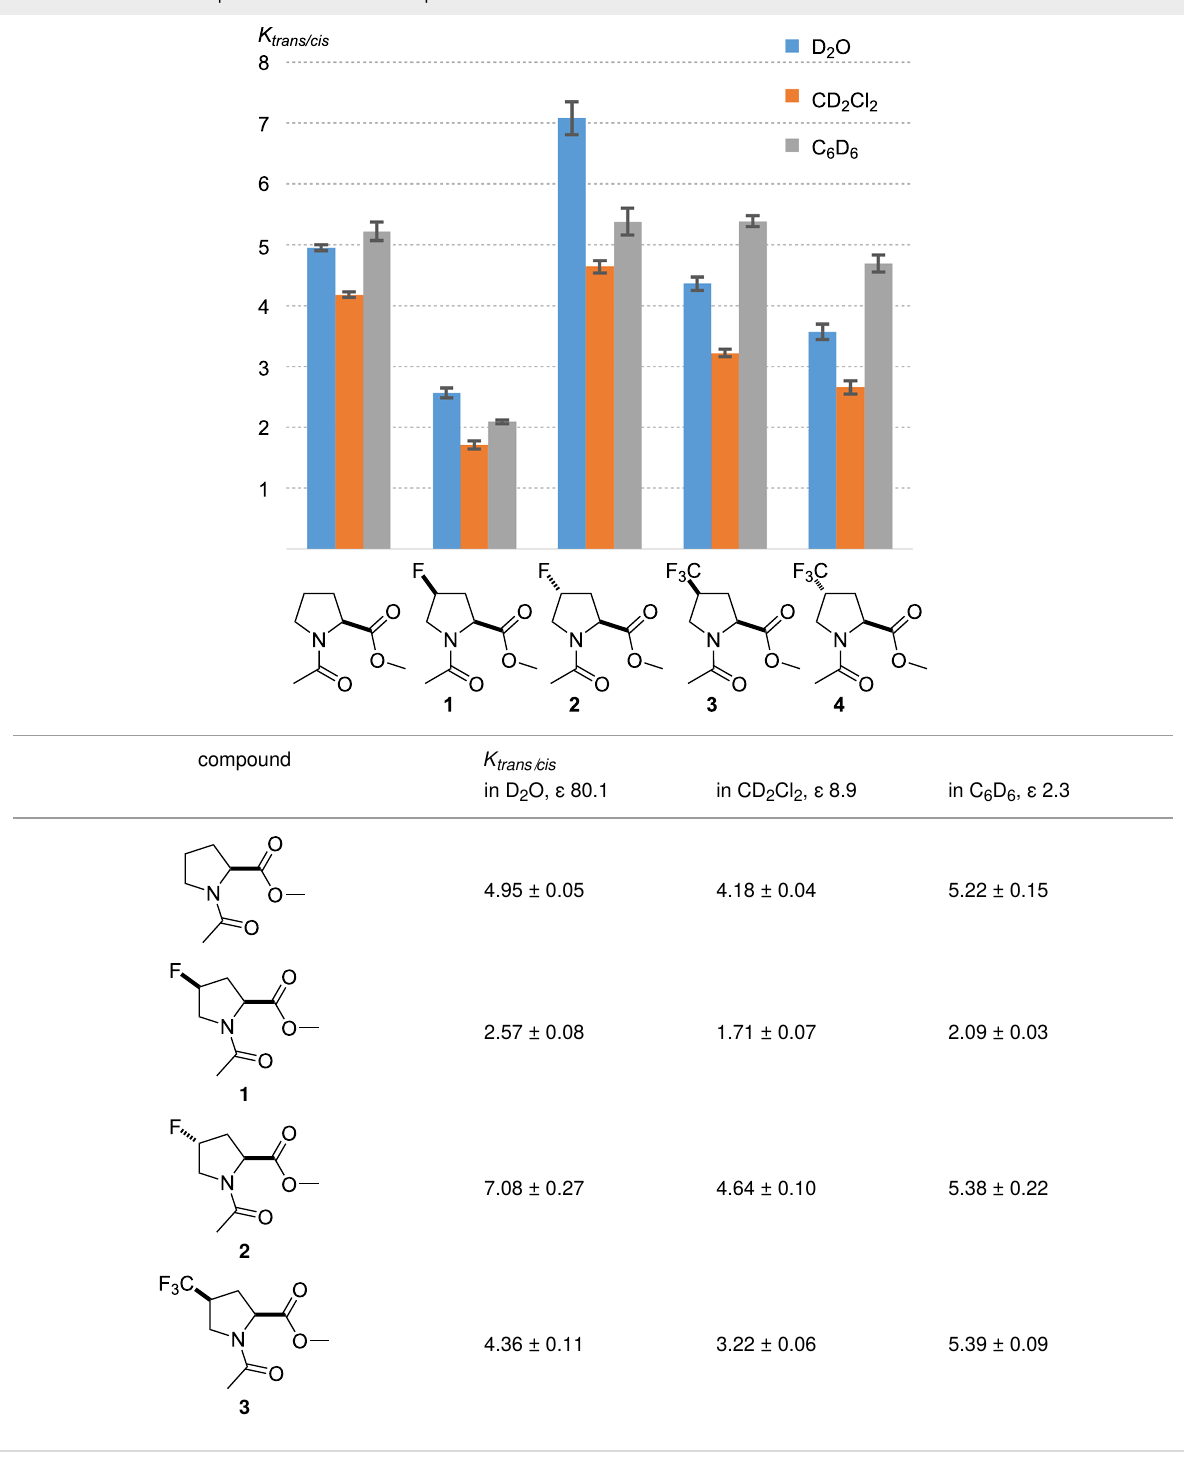
Table 2: Amide-rotation equilibrium in the model compounds.